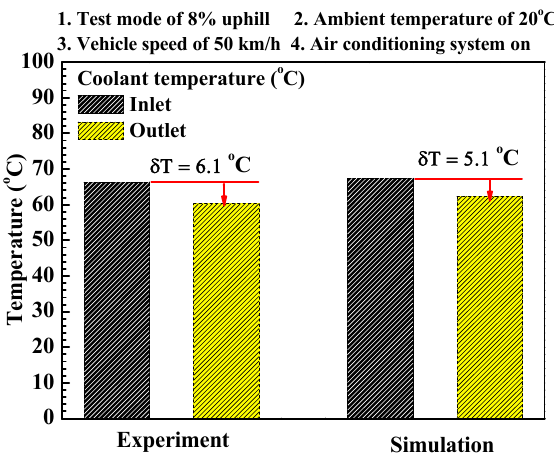
Figure 5. Comparison of cooling performance, as determined under actual road-driving conditions and from simulations. Energies 2016 , 9 , 320